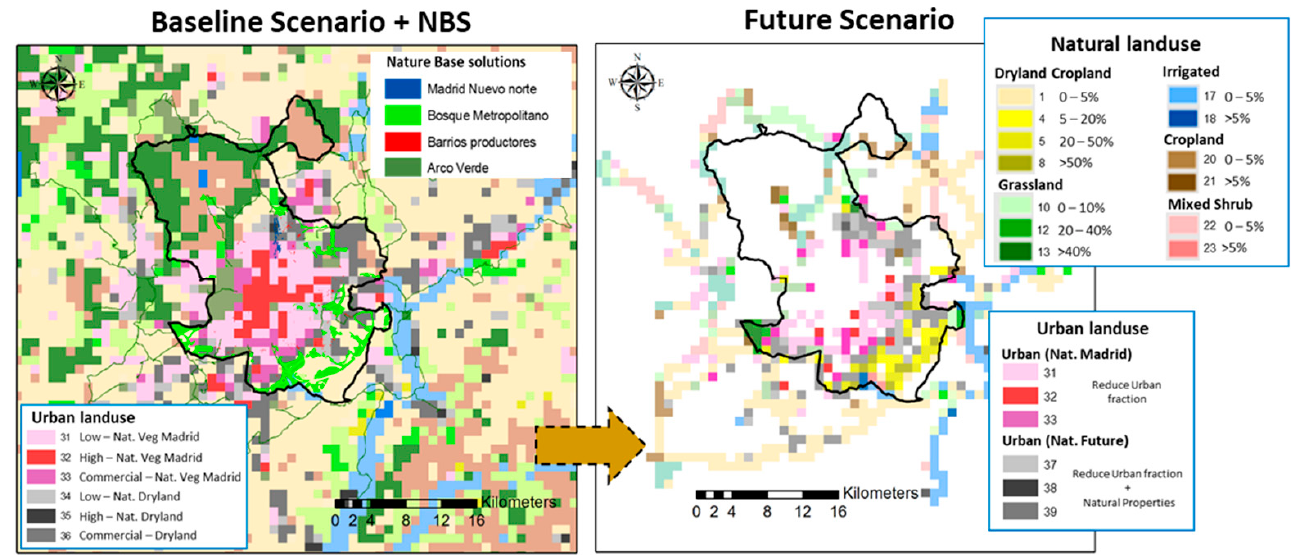
Figure 2. Baseline scenario along with the NBS-based interventions envisaged in the Future Scenario ( left ). Model grid cells affected by those vegetation changes and land-use category assigned in the Future Scenario ( right ).